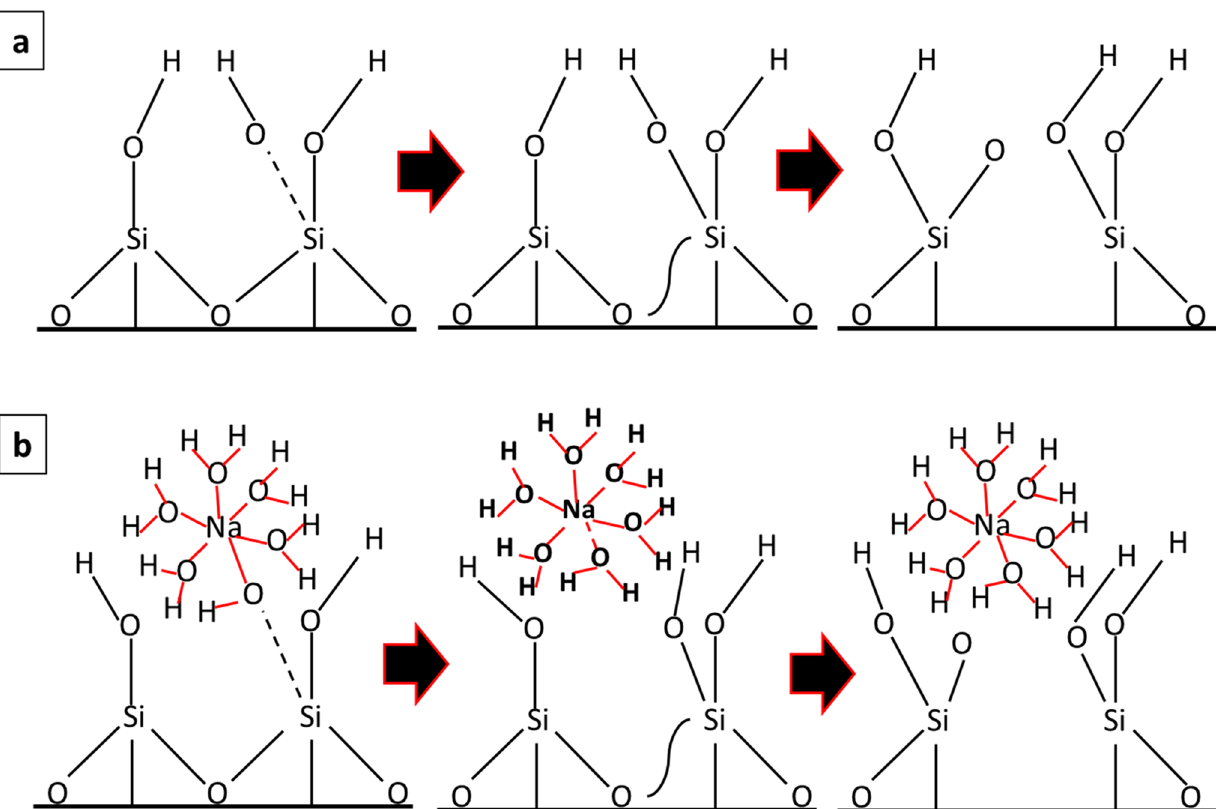
Fig. 2 Graphical representation of NaOH hydrolysis of quartz (Bickmore et al.